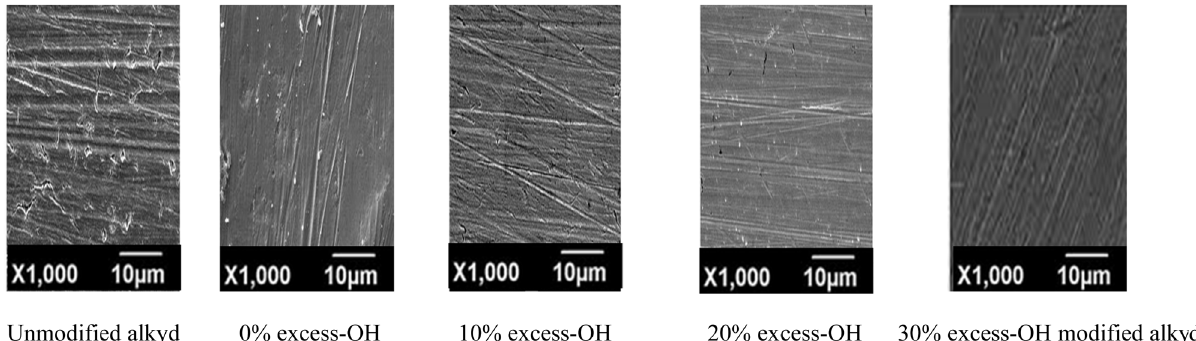
Figure 7: SEM images of the steel surface after corrosion for unmodi fi ed and 0%, 10%, 20%, and 30% excess - OH of modi fi ed alkyd